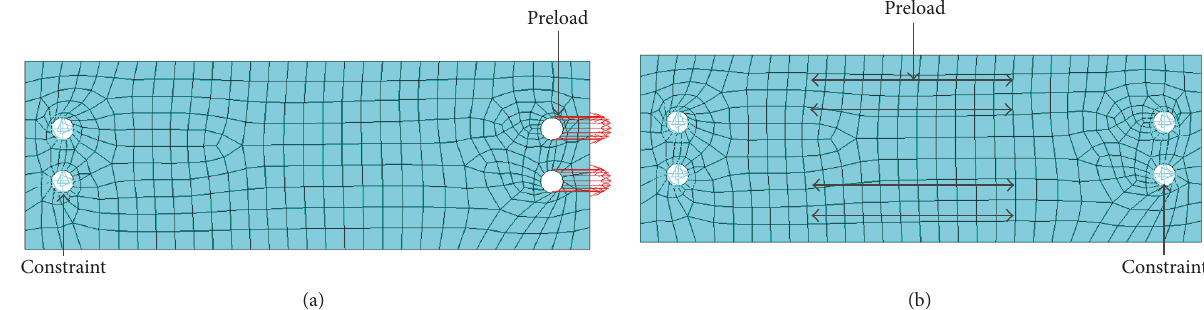
Figure 3: ANSYS simulation model of thin plates. (a) Loading simulation. (b) Dynamics simulation.